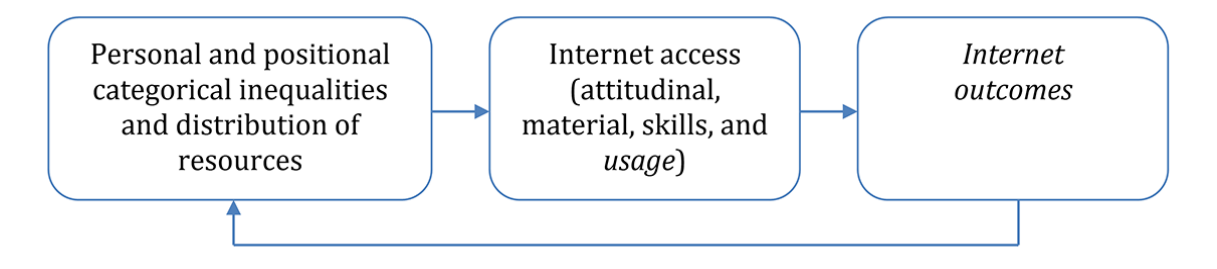
Figure 1. Simplified model of the resources and appropriation theory